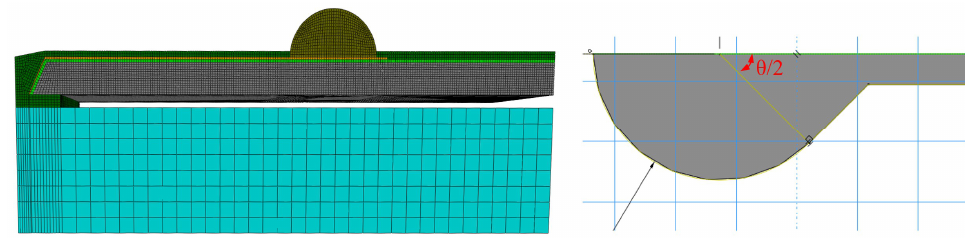
Figure 7. The strip model of WLCSP for di ff erent UBM design.